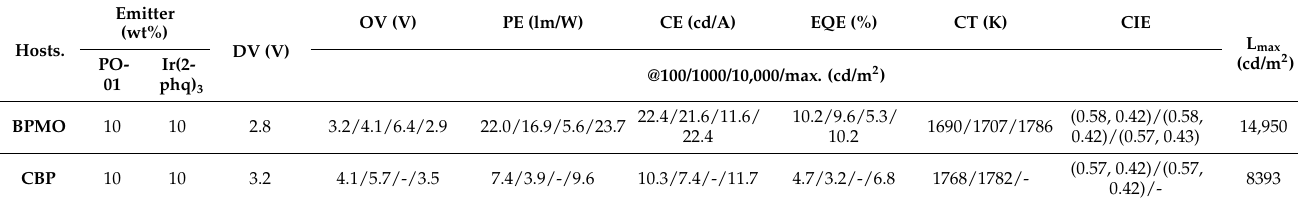
Table 2. Power efficacy (PE), current efficacy (CE), EQE, color-temperature (CT) of studied BPMO- and CBP-based candlelight organic LED using (at 10 wt%) yellow (PO-01) and orange-red (Ir(2-phq) 3 ) emitters.